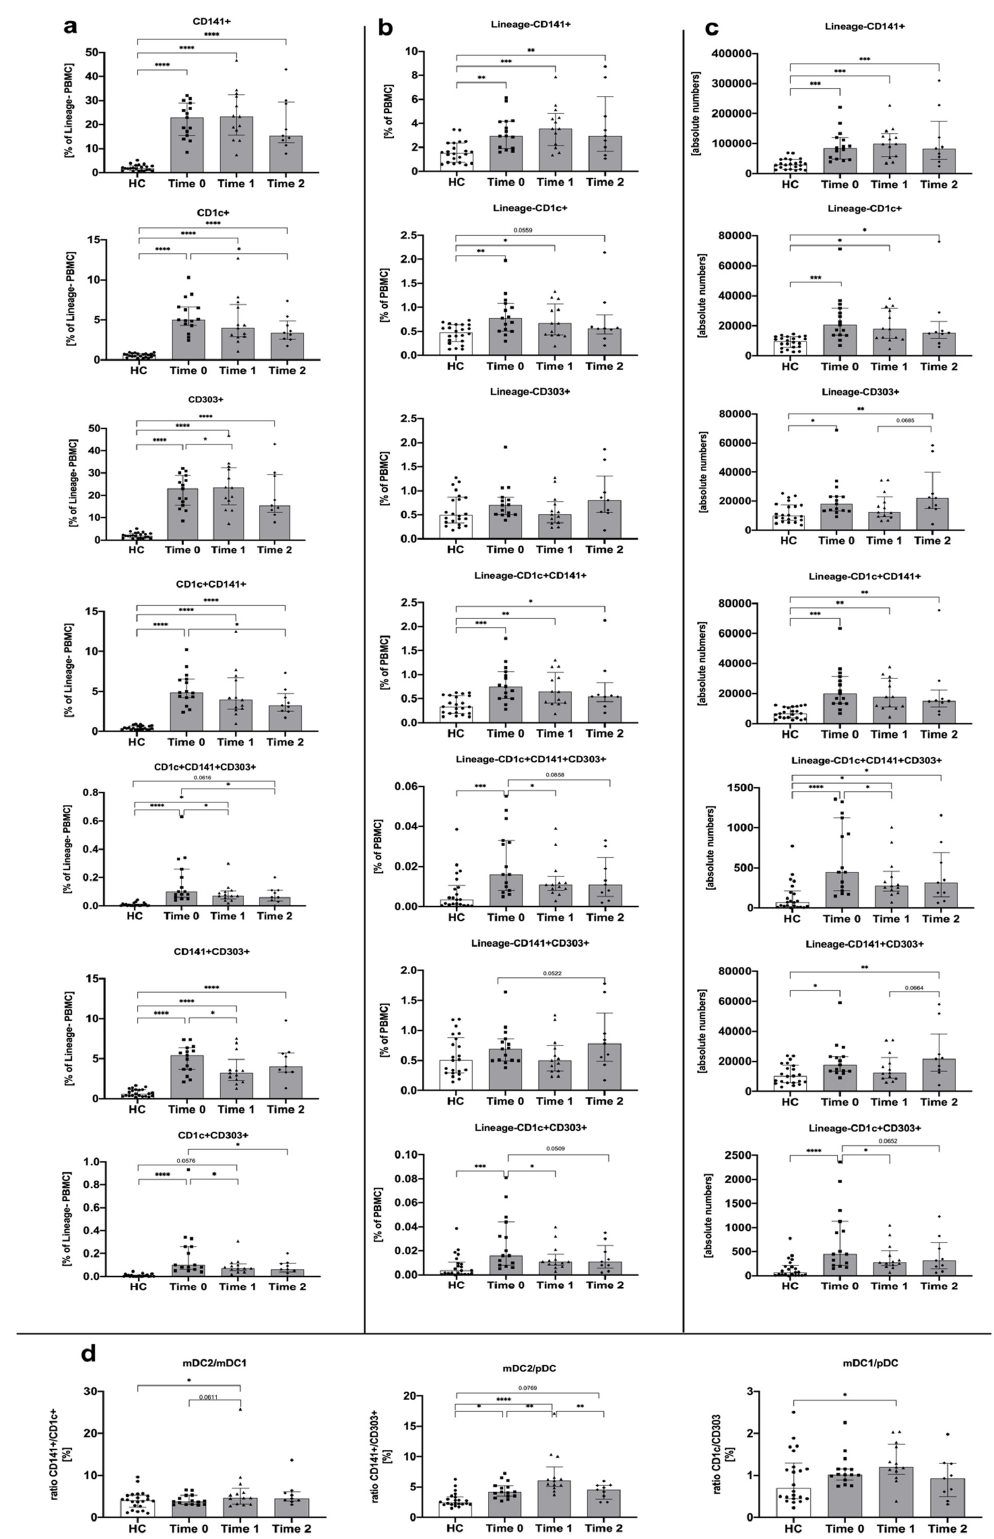
Figure 2. Changes in dendritic cell-related parameters in the course of Graves’ disease patients’ treatment: before treatment (Time 0) and after 3 months (Time 1) and 1 year of treatment (Time 2). Acquired data were analyzed in the context of DC subset frequency within Lineage-negative PBMCs ( a ), the total pool of PBMCs ( b ), as an absolute number of cells ( c ), and the ratio between studied DCs ( d ). Data are presented on each graph as the median with interquartile range. The levels of significant differences were indicated with: * p < 0.05; ** p < 0.01; *** p < 0.001; **** p <